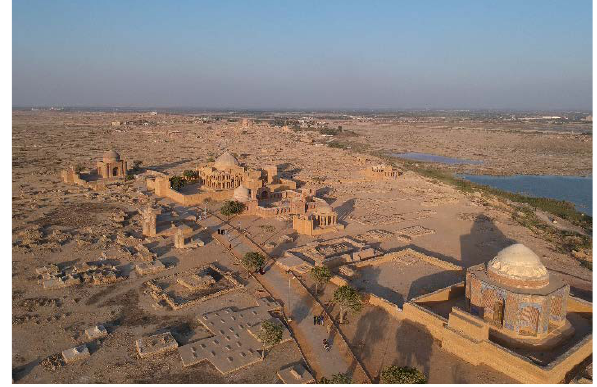
Figure 1. Overall view of the first cluster of structures at the south of Makli. The site extends for six kilometers to the north.